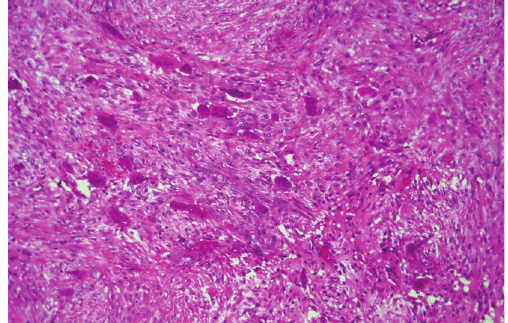
Figure 11: Cherubism: osteoclast-like giant cells lie in a fibroblastic background. Central giant cell granuloma shows an identical picture; therefore distinction between both is made on clinical and radiological